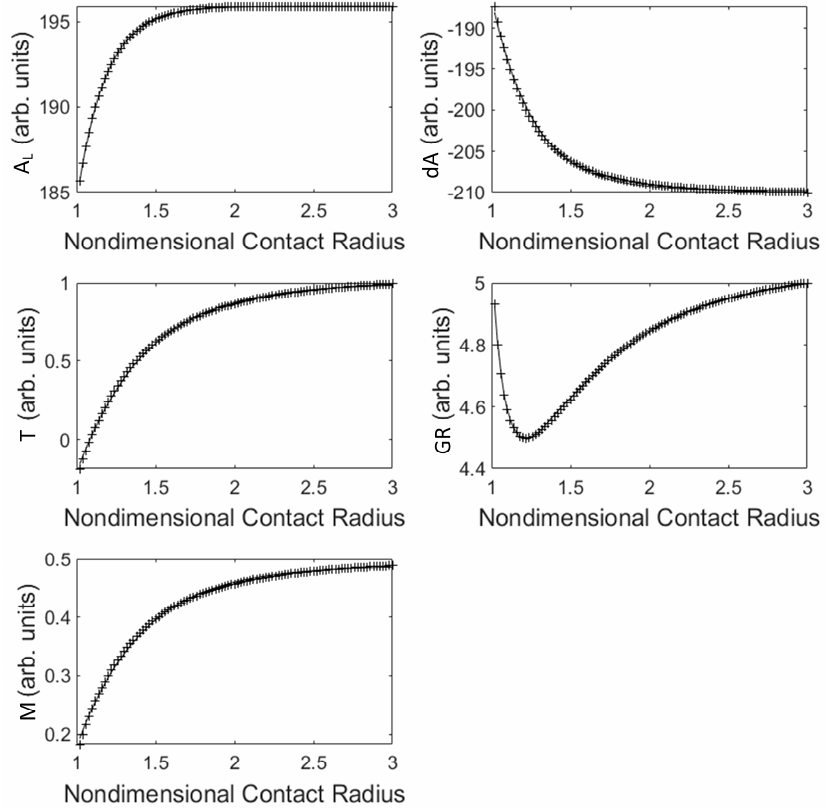
Figure 8. Comparison of the coe ffi cients generated as a result of the fit of Equation (16) to the contact angle as a function of the normalised dimensionless gap data shown in Figure 7 for increasing nondimensional contact radii and the functions given by Equation 17.